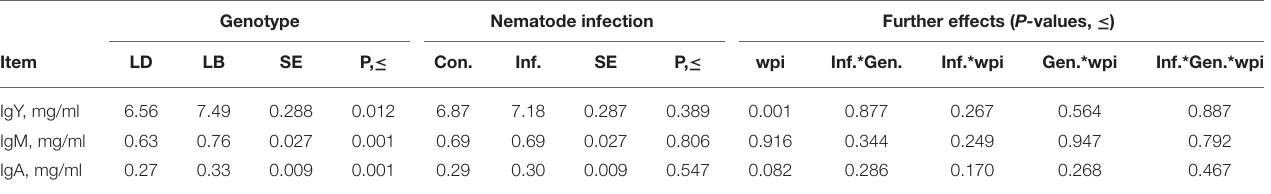
TABLE 2 | Concentrations of total immunoglobulin isotypes, IgY, IgM, and IgA in plasma samples of laying hens of Lohmann Brown Plus (LB) and Lohmann Dual (LD) genotypes exposed to an experimental mixed-nematode-infection (Inf.) or kept as uninfected control (Con.). Genotype Nematode infection Further effects ( P- values, ≤ )